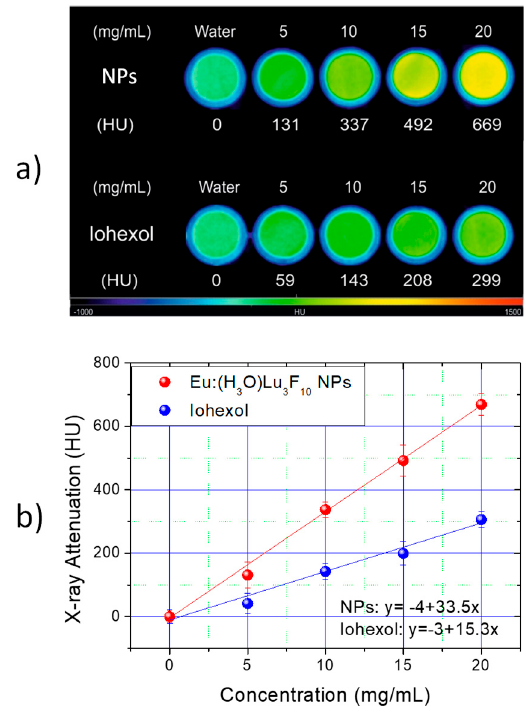
Figure 8. Computed tomography (CT) phantom images ( a ) and HU values ( b ) of 10% Eu-containing ff erent concentrations in (H 3 O)Lu 3 F 10 nanoparticles and Iohexol at different concentrations in water. (H 3 O)Lu 3 F 10 nanoparticles and Iohexol at di